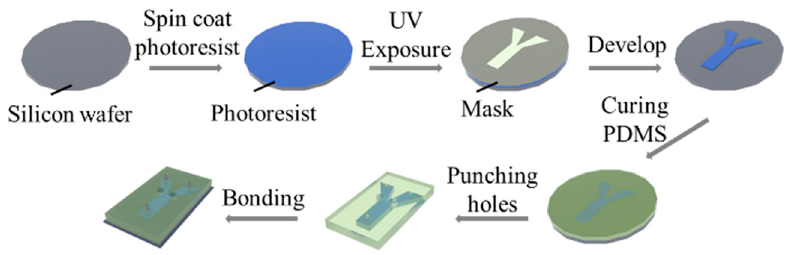
Figure 3. Schematic diagram of the fabrication process of the micromixer chip.